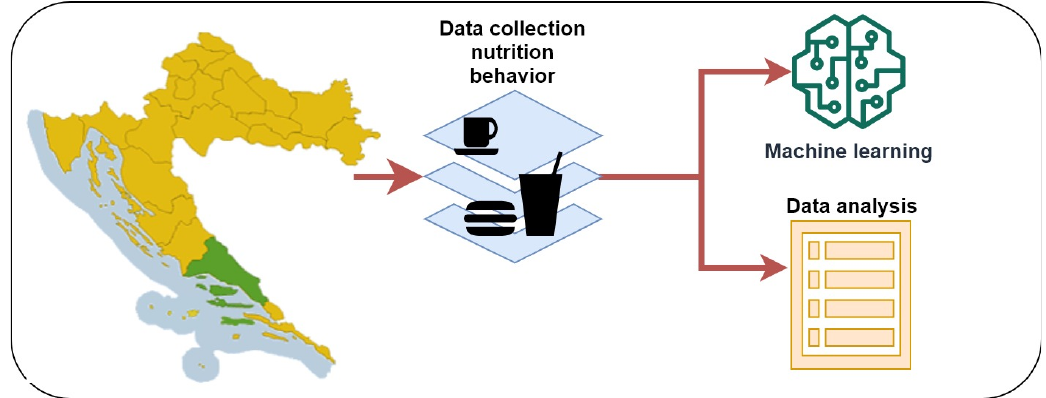
Figure 1. Graphical abstract of the present study.